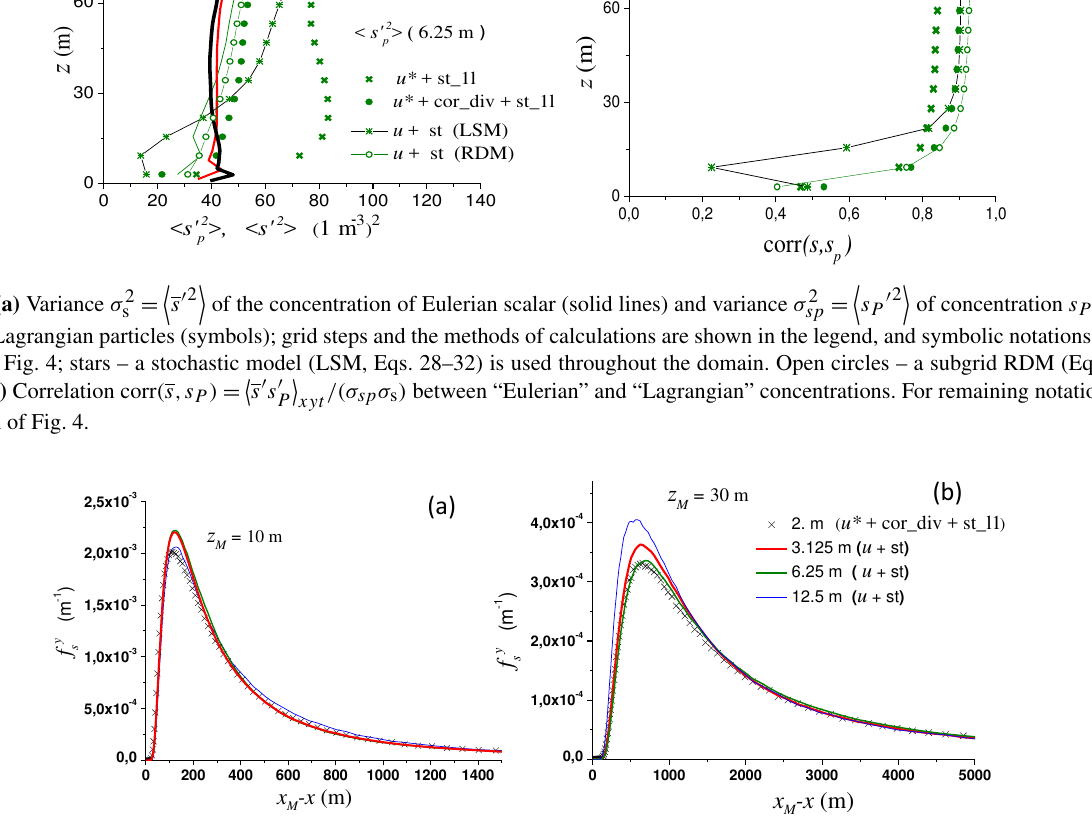
Figure 6. Crosswind-integrated scalar flux footprints f y s , computed using the stochastic subgrid model (Eqs. 28–32): (a) sensor height z M = 10m; (b) z M = 30m. Grid steps are given in the legend. Crosses denote footprints computed with the subgrid LSM applied for the particles within the first grid layer